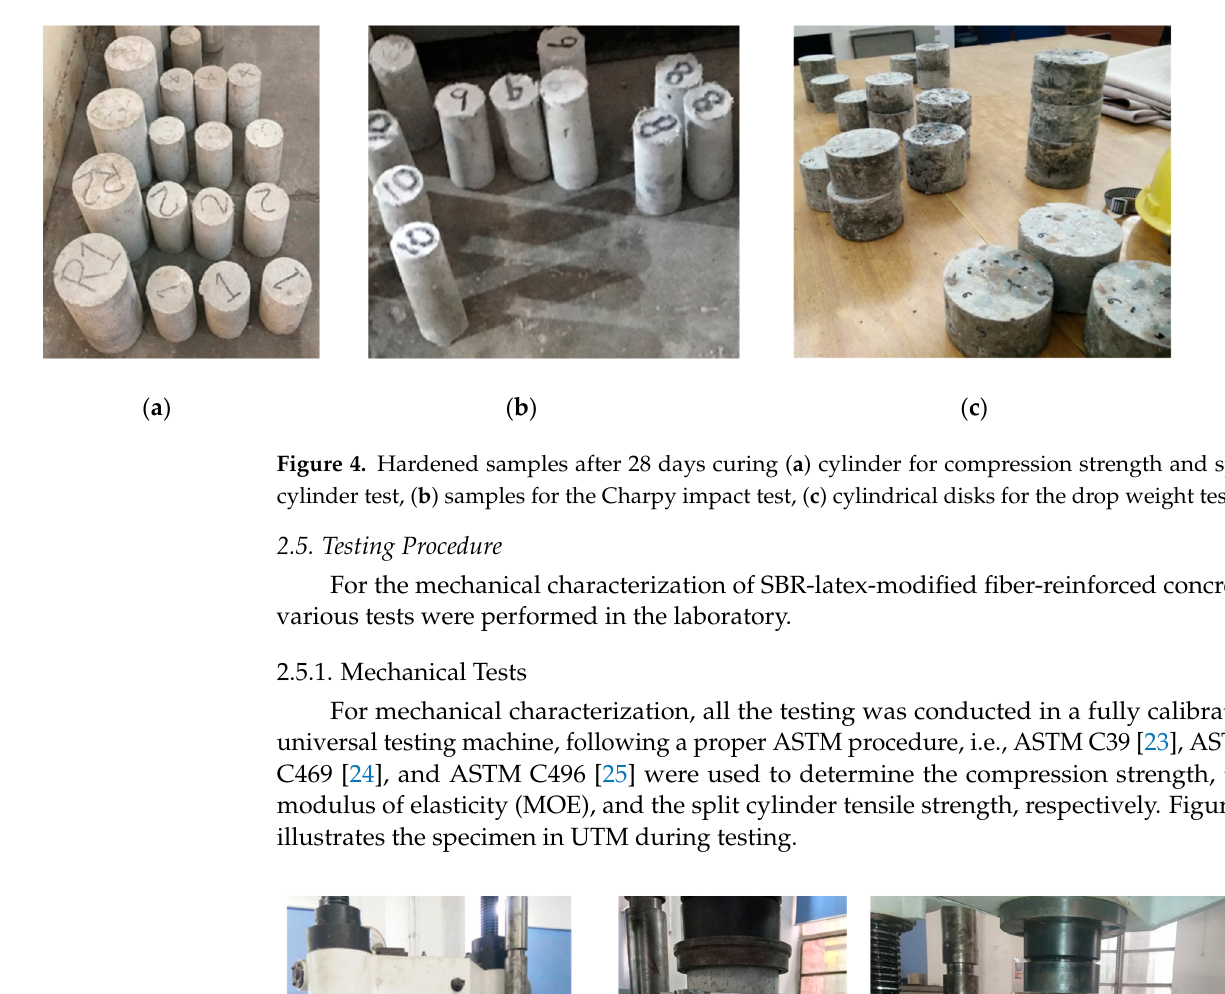
Figure 3. Various steps involved in concrete mixing: ( a ) addition of polypropylene fibers during dry mixing; ( b ) inclusion of liquid-based SBR latex; ( c ) vibration after casting; and ( d ) fibrous concrete after mixing.